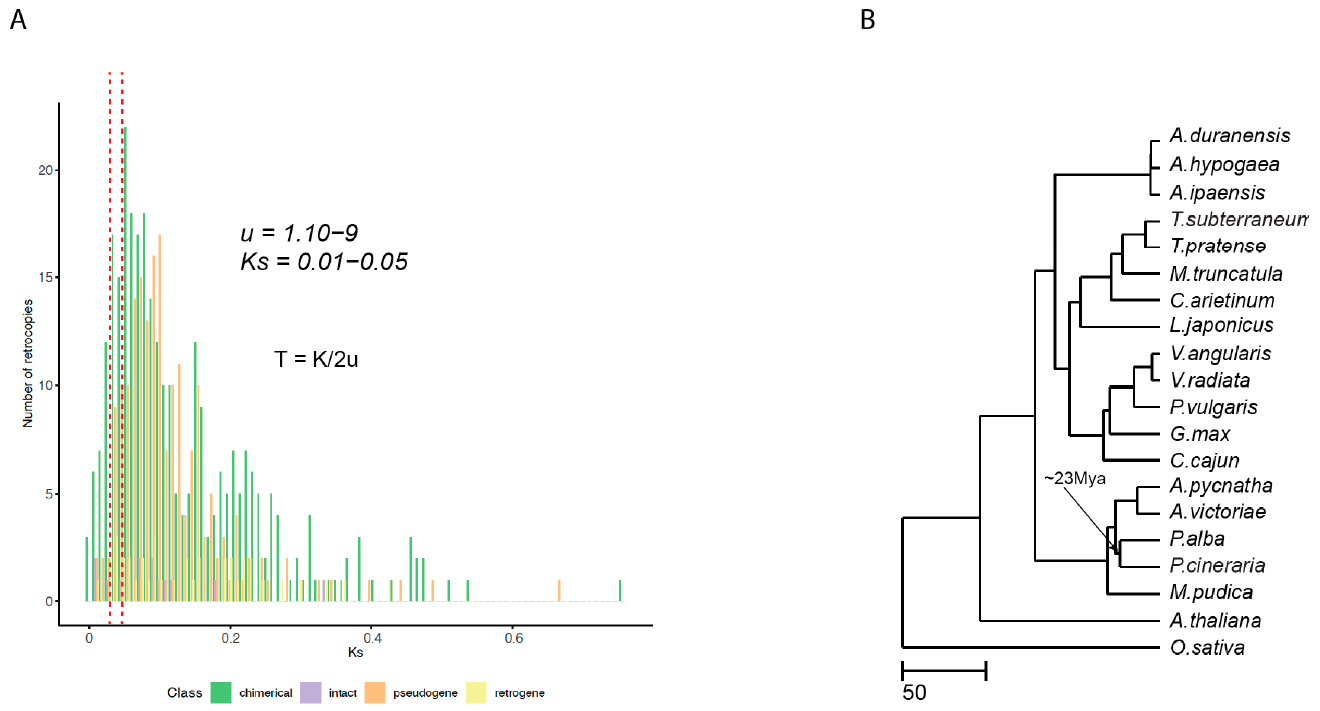
Figure 5. The timing of chimerical retrogene generation in P. cineraria . ( A ) Ks distribution of the different classes of retrogenes. The red dotted lines around Ks = 0.01–0.05 highlights the initial amplification. ( B ) Ultrametric tree highlighting the time of divergence of P. cineraria and P. alba , which overlaps with major amplification of chimerical retrogenes, using a mutation rate of 10 − 9 and using the formula (T = k/2u).